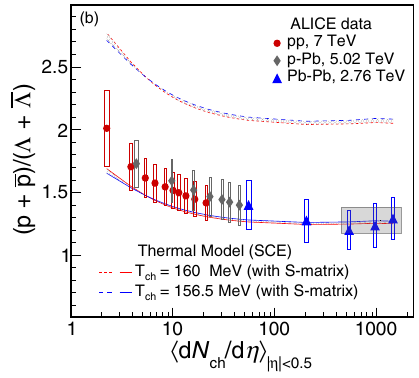
Figure 2. Left: Yields for V A = V C . Right: Yields for V A (cid:31) V C , The two top lines are the fitted volumes V A (x5) in fm 3 . The particle yields are indicated together with the multiplicative factor used to separate the yields. The solid blue lines have been calculated for T = 156.5 MeV while the solid red lines have been calculated for T = 160 MeV. The values of the volumes used have been parametrized empirically (see text for more details).